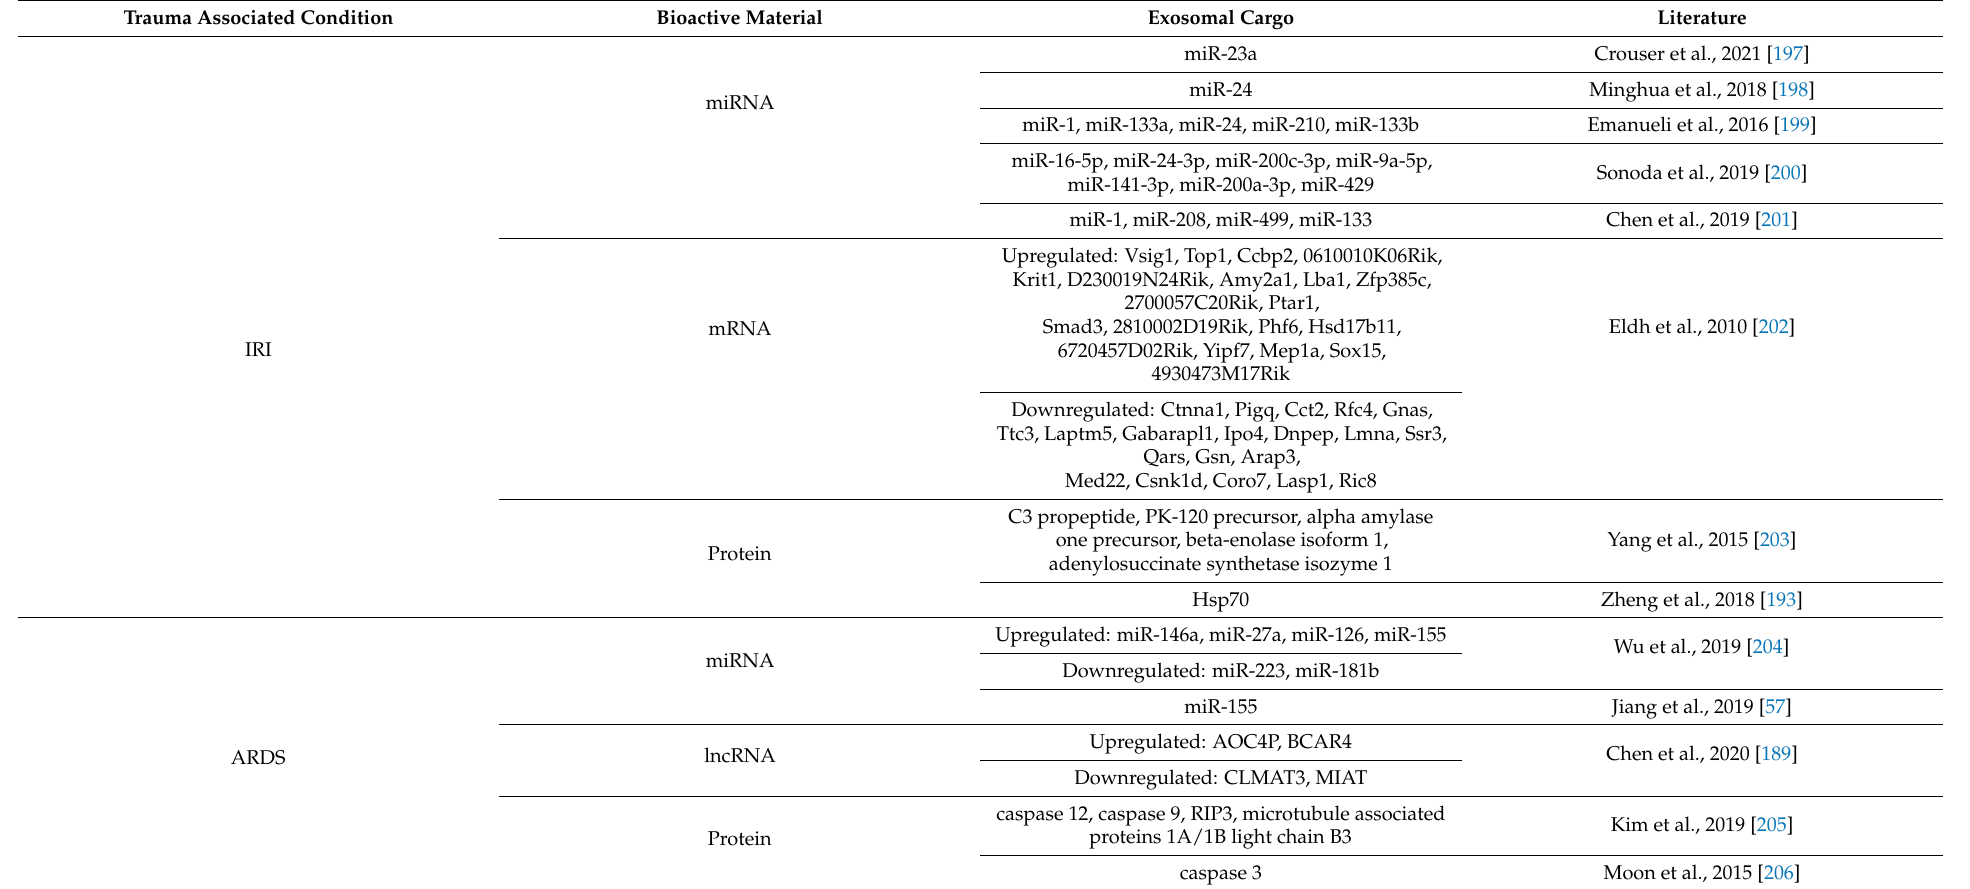
Table 1. Summary table of bioactive cargo of exosomes in trauma-associated inflammatory complications. This table specifically highlights micro-RNA (miRNA), messenger RNA (mRNA), and proteins found in exosomes associated with ischemic reperfusion injury (IRI), acute respiratory distress syndrome (ARDS), and